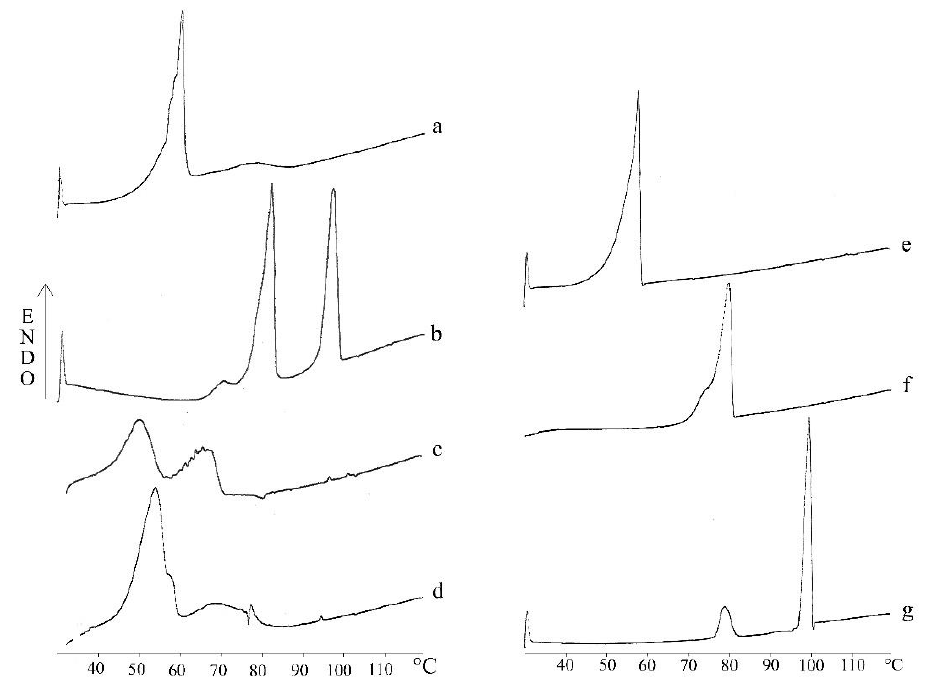
Figure 3. DSC thermograms of stearic acid/PEA physical mixture ( a ), cholesteryl stearate/PEA physical mixture ( b ), PEA-SLNs ( c ), lipid blend/PEA physical mixture ( d ), stearic acid in bulk ( e ), cholesteryl stearate in bulk ( f ), and PEA in bulk ( g ).